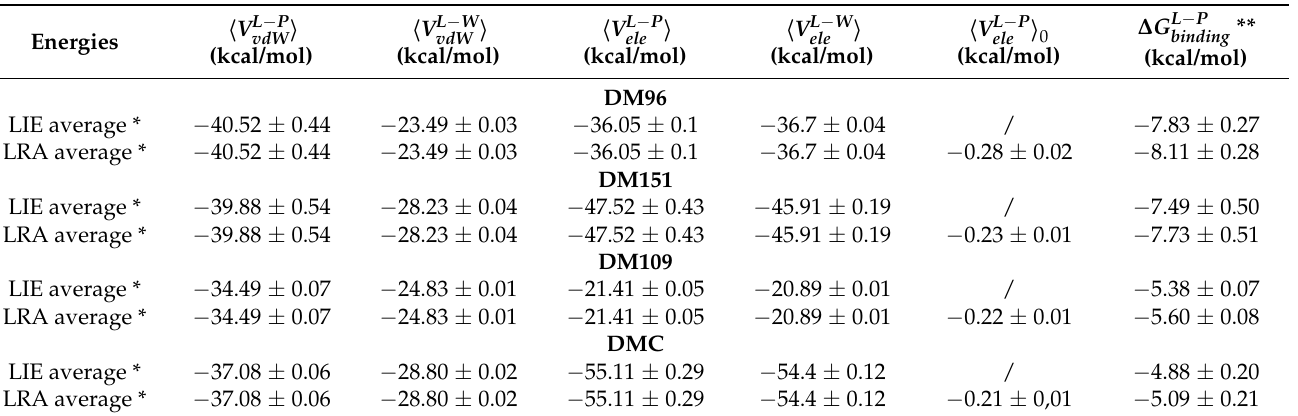
Table 6. The average electrostatic (ele) and van der Waals (vdW) non-bonded interactions of DM96, DM151, DM109, and DMC in water (the free state W) as well as in complex with hGSTP1-1 (the bound state P) along with the corresponding binding free